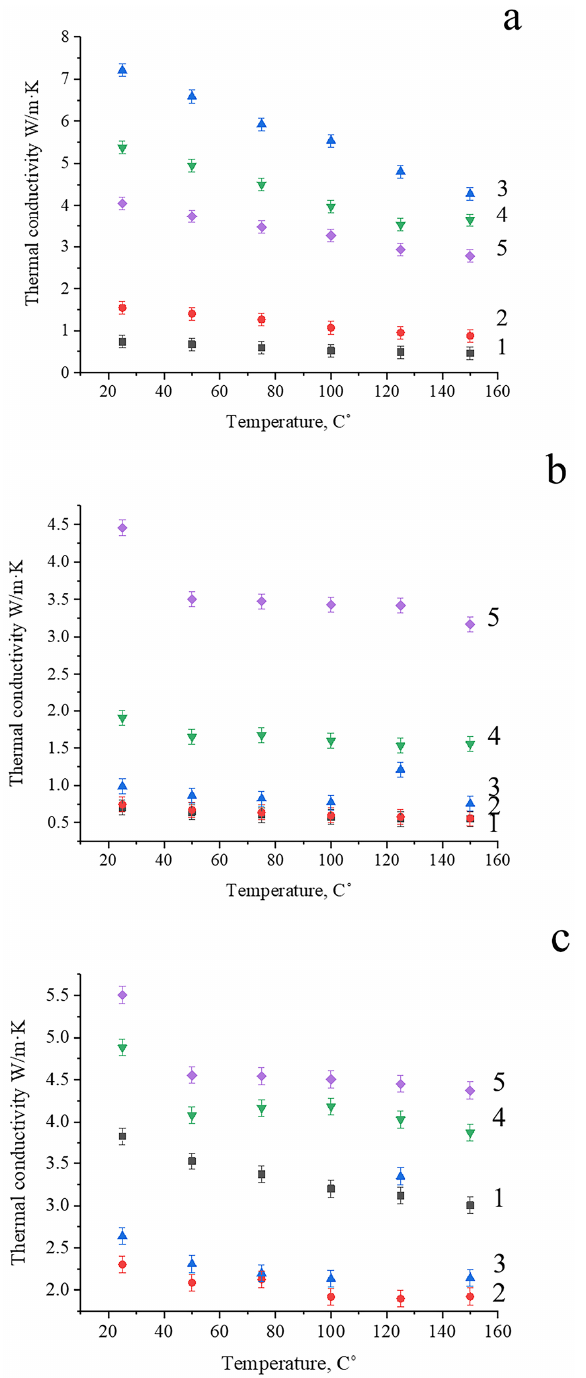
Figure 8. Thermal conductivity temperature dependencies of PSU-based composites filled with 0 (1), 30 (2), 40 (3), 50 (4), 60 (5) and 70 (6) wt.% of NG ( a ), AG ( b ) and EG ( c ).